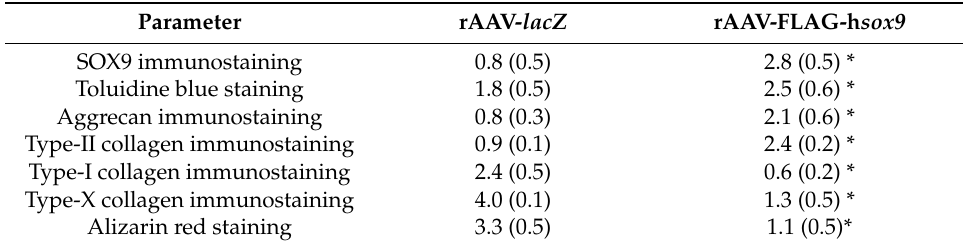
Table 1. Effects of SOX9 overexpression on the histomorphometry of the fibrin-PU scaffolds seeded with rAAV-transduced